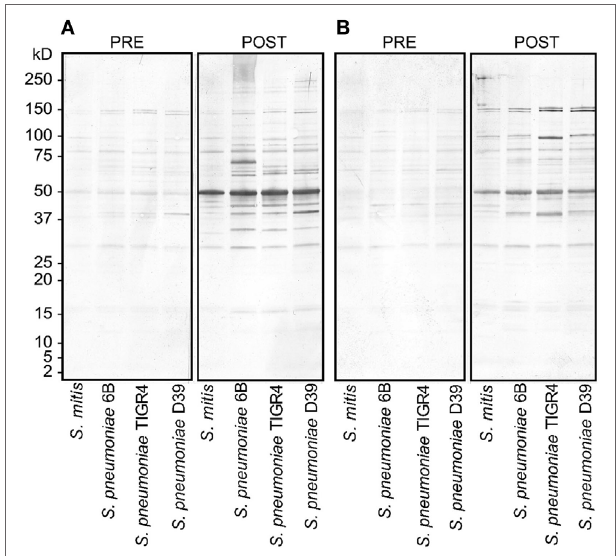
FigUre 1 | Reactivity of rabbit antisera raised against Streptococcus mitis with Streptococcus pneumoniae strains (6B, TIGR4, and D39) by SDS-PAGE in gradient gels and immunoblotting. Each lane was loaded with 50 µg of protein from the indicated bacterial species. The pre- and post-inoculation sera were diluted 1:1,000. (a,B) Antisera from rabbit-1 and rabbit-2, which were immunized with S. mitis CCUG31611. The experiment was performed twice. Abbreviations: PRE, pre-inoculation sera; POST, post-inoculation